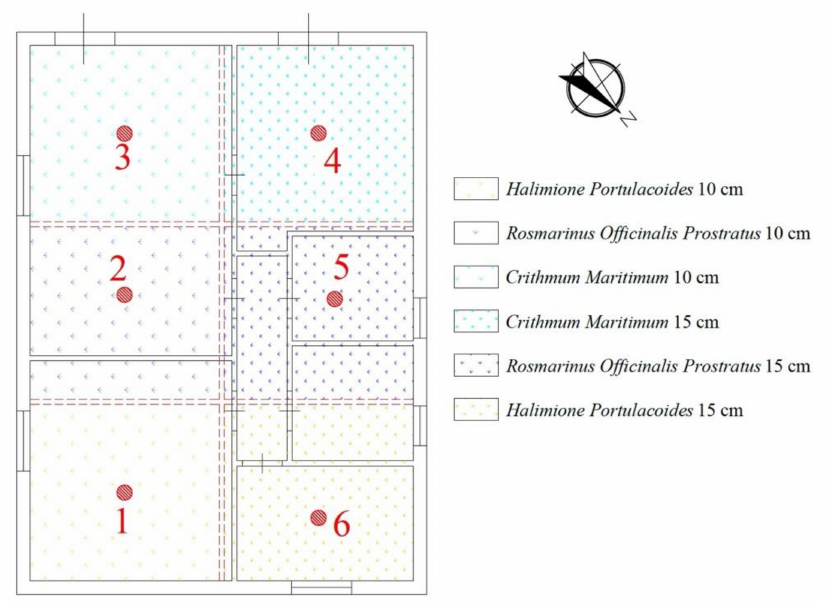
Figure 8. Layout of the building, green roof plots’ arrangement and positions of probes for the temperature